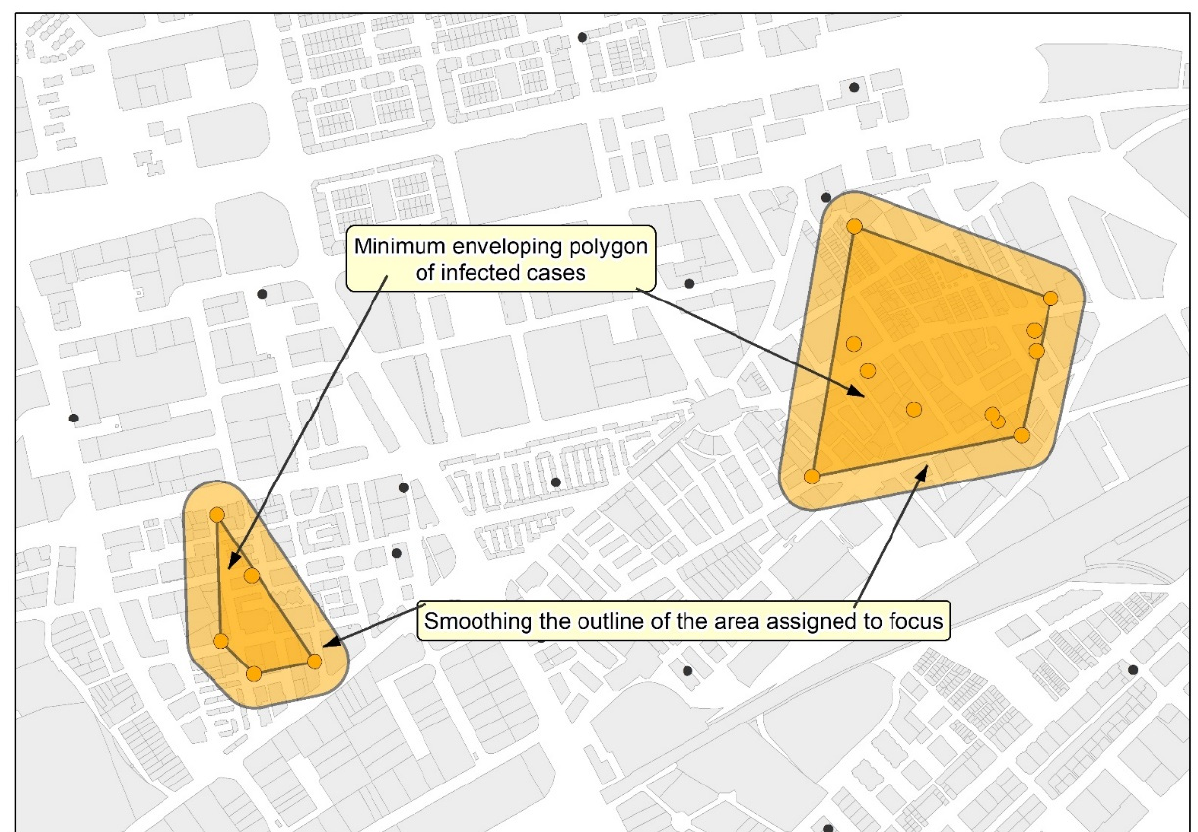
Figure 6. Assignment of the area corresponding to the different infected people (focus) groups and smoothing the limit of the focus.